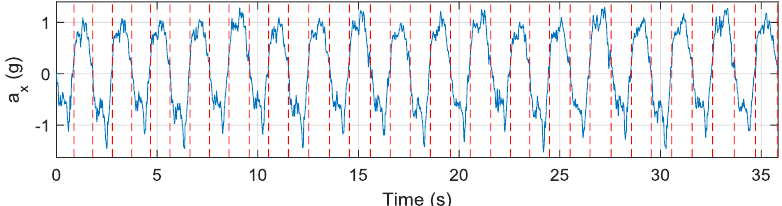
Figure 3. Mediolateral acceleration (gravity corrected, blue) with the overlapping zero-crossing detection result (red).